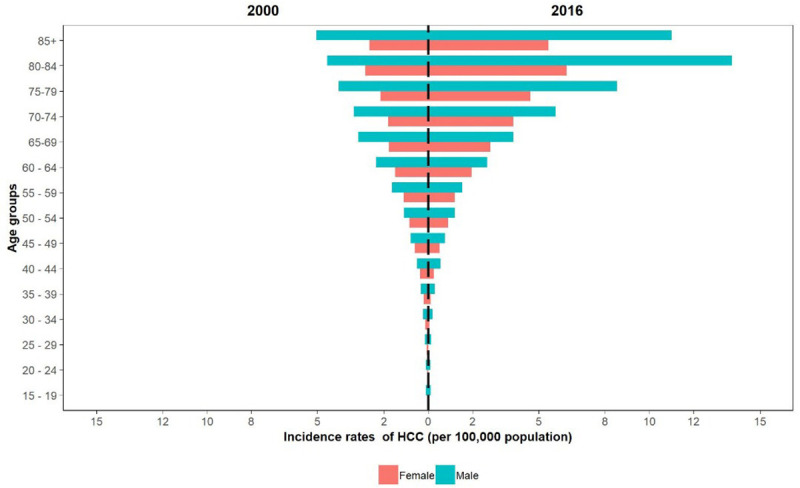
Comparison of incidence rate of HCC by age group and sex, 2000 vs 2016.